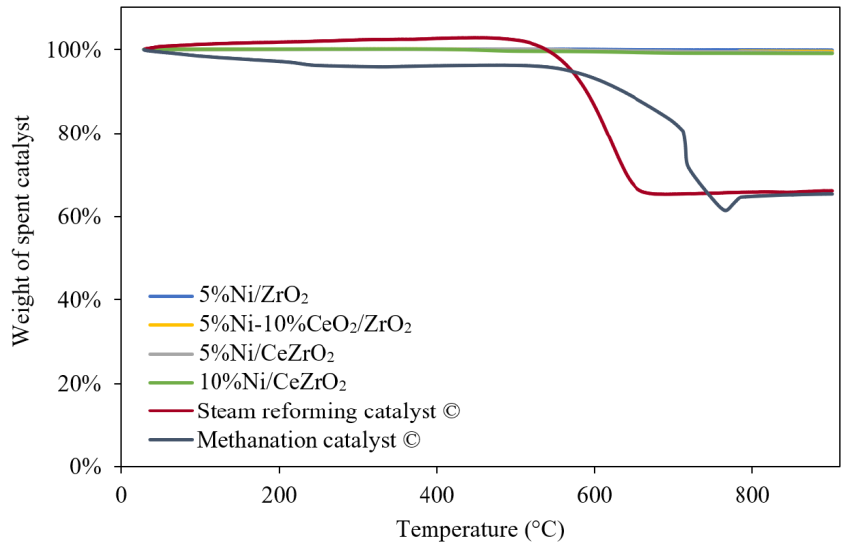
Figure 9. TGA patterns for spent catalyst.